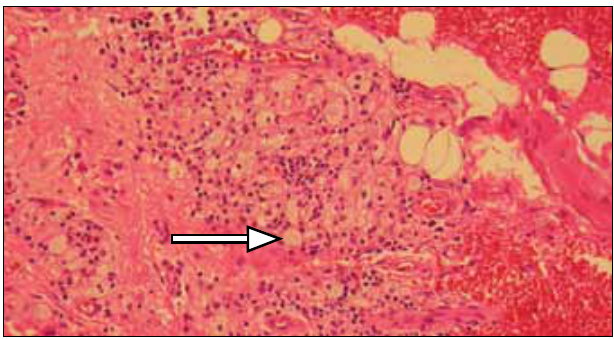
Fig 7. Haematoxylin and eosin stain showing mixed chronic inflammation with foam cells (arrow).